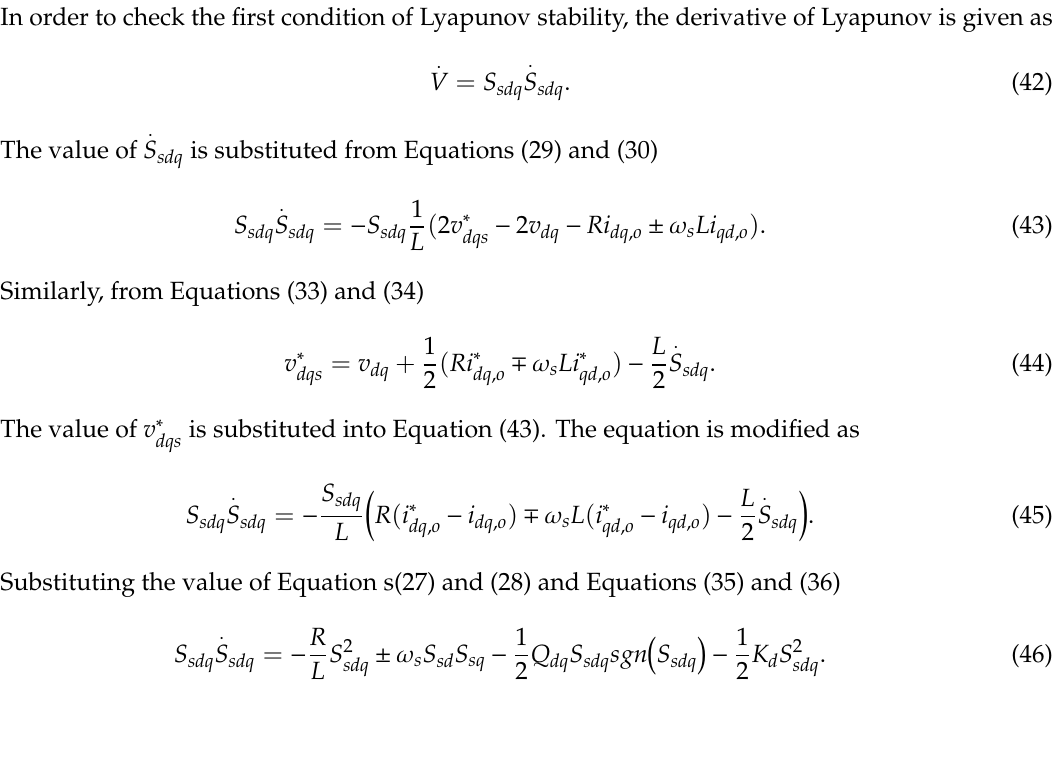
Figure 5. Output current control structure .